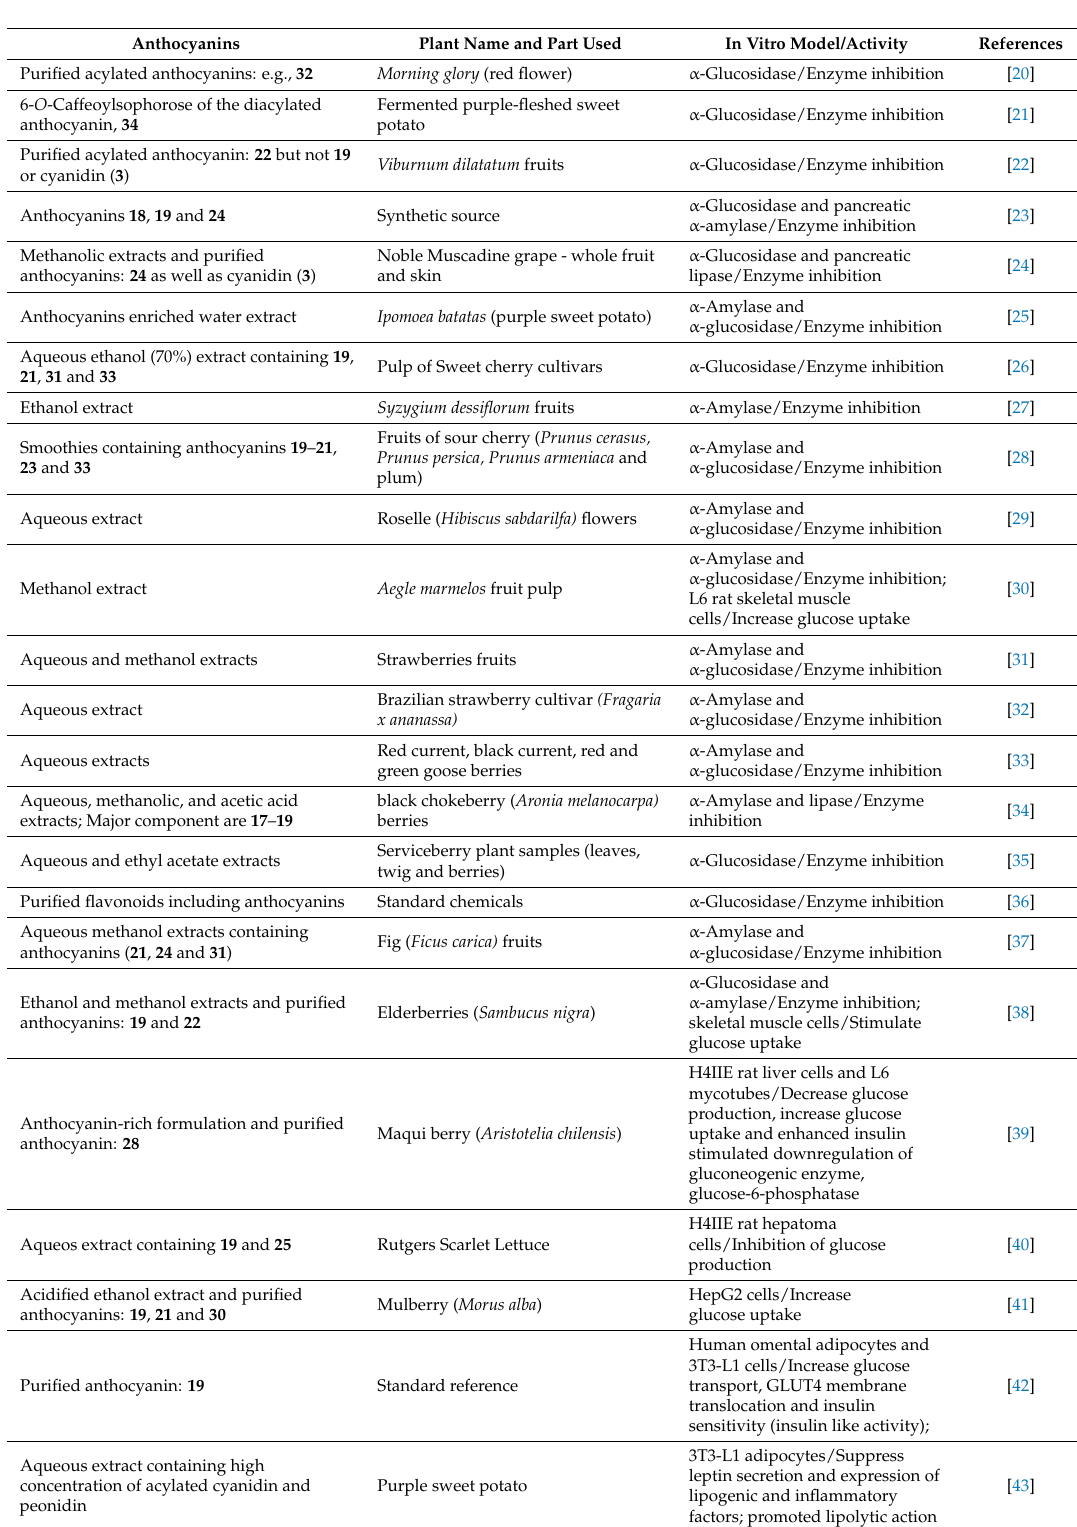
Table 2. In vitro modulatory effects of anthocyanins against insulin resistance and